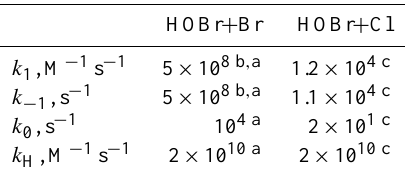
Table 3. Underlying rate constant data ( k 1 , k − 1 , k 0 , k H ) used in k II parameterisations of Fig.